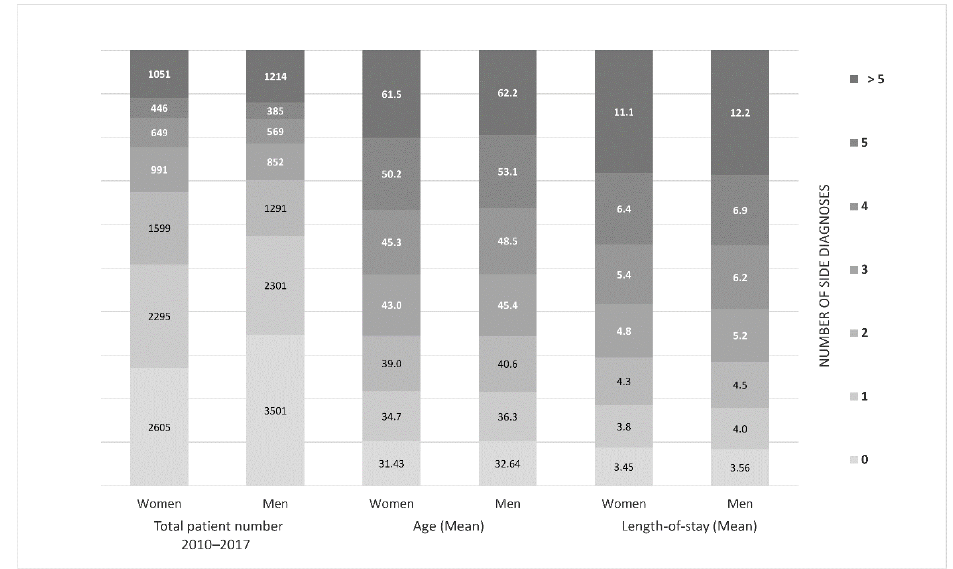
Figure 5. Number of secondary diagnoses: men compared to women. Mean age and mean duration of hospitalization of all patients with a main diagnosis of acute appendicitis in all appendectomy cases, 2010–2017 ( n = 19,749).